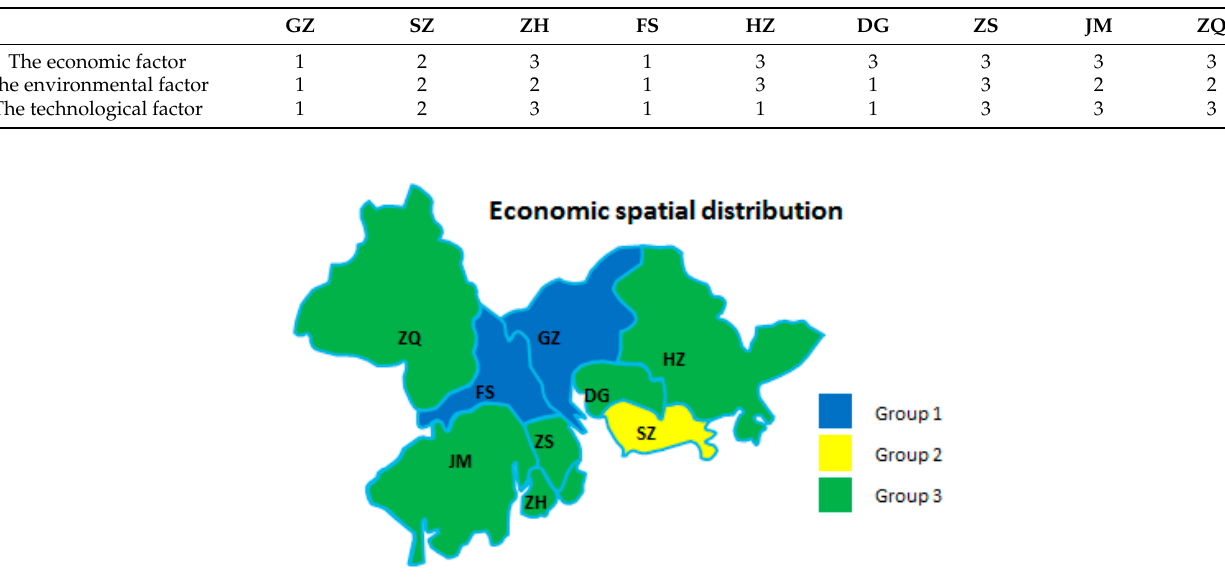
Figure 3. Economic spatial distribution of the nine cities.